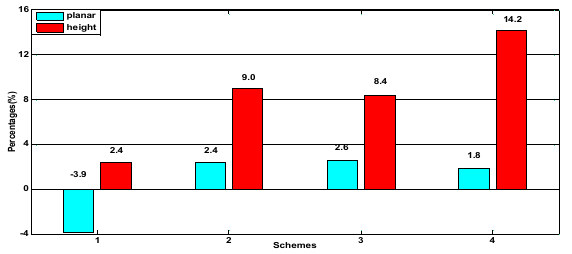
Fig. 4. Improved percentage of LSC approach based on ATM with respect to traditional approach based on